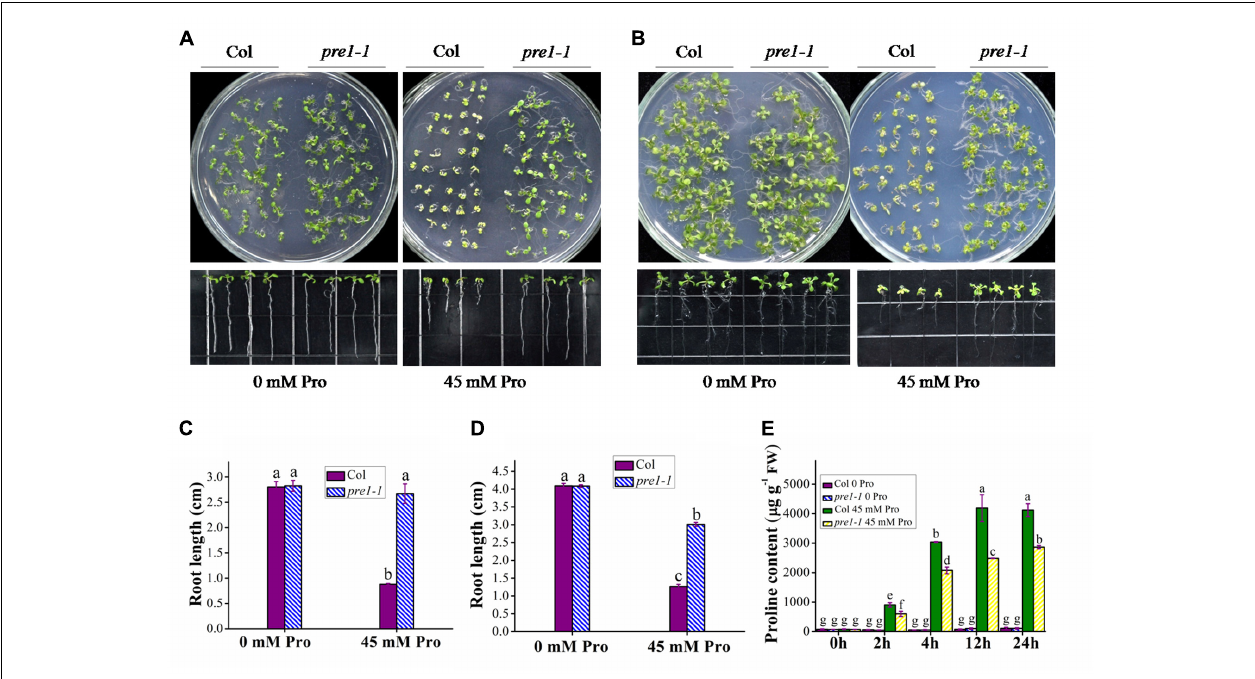
FIGURE 1 | The proline-tolerant phenotype of pre1-1 mutants. Growth of wild-type (Col) and pre1-1 seedlings (A,B) and average root length (C,D) on 0.5 × MS medium supplemented with 45 mM L -proline (Pro) following 10 (A,C) or 16 (B,D) days of growth. (E) The proline contents of 12-day-old wild-type and pre1-1 seedlings treated with 45 mM proline in 0.5 × MS liquid medium for various time periods. Experiments were repeated a minimum of three times with similar results. Data are means ± standard error ( n = 6). Different letters above columns indicate significant difference ( P < 0.05, Duncan’s multiple range